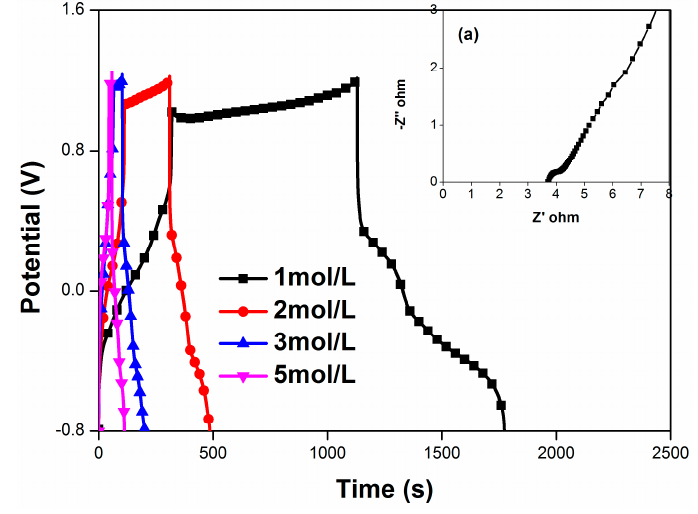
Figure 7. GCD and EIS (inset Figure 7a) curves of PANI/A-MWCNTs in a two-electrode system.